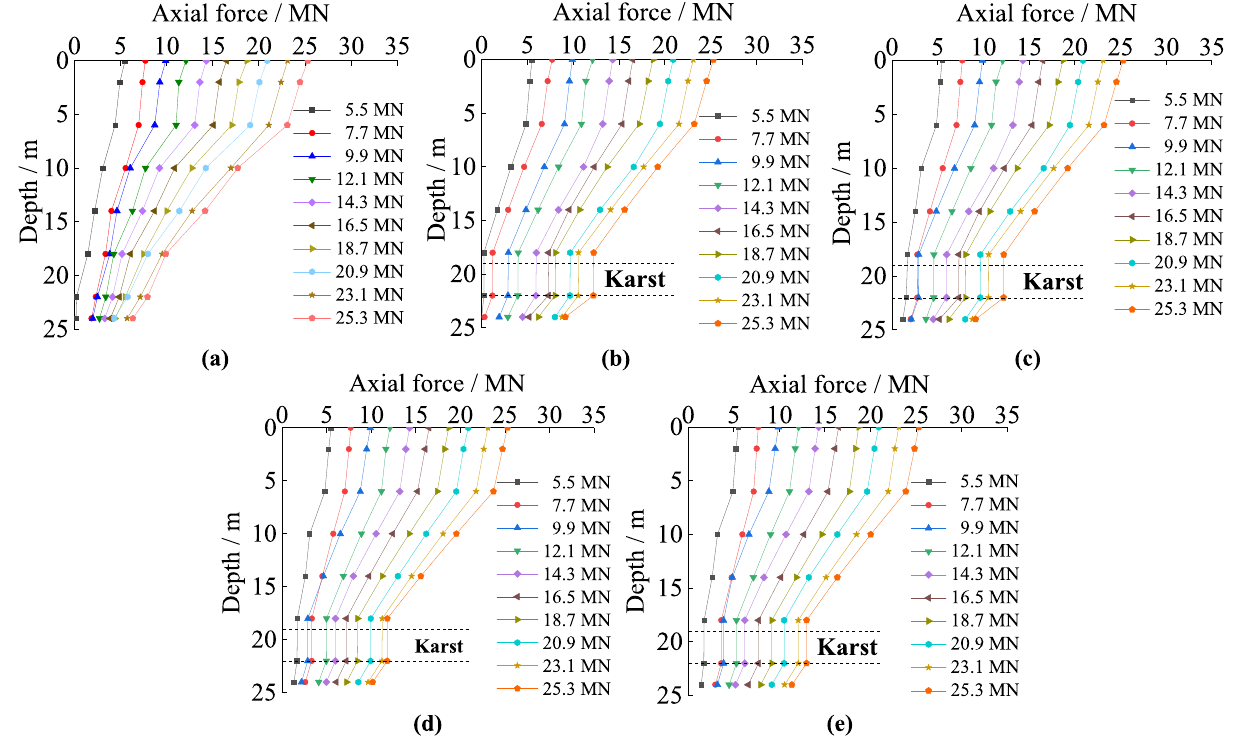
Figure 4. The axial force of piles with different karst cave spans: ( a ) no cave; ( b ) cave’s span is 3 m × 3 m; ( c ) cave’s span is 6 m × 6 m; ( d ) cave’s span is 9 m × 9 m; ( e ) cave’s span is 12 m × 12